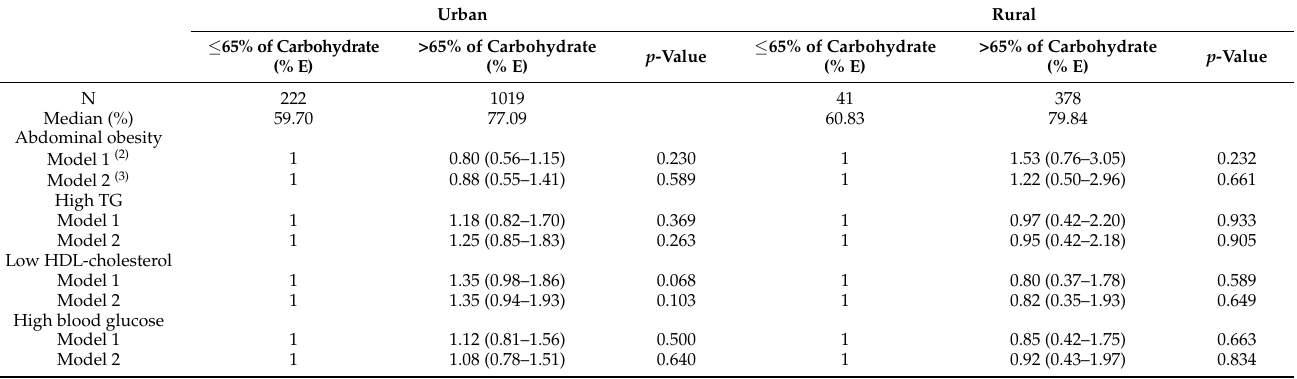
Table 7. OR of metabolic abnormalities according to the percentage of energy from carbohydrate in women (1)